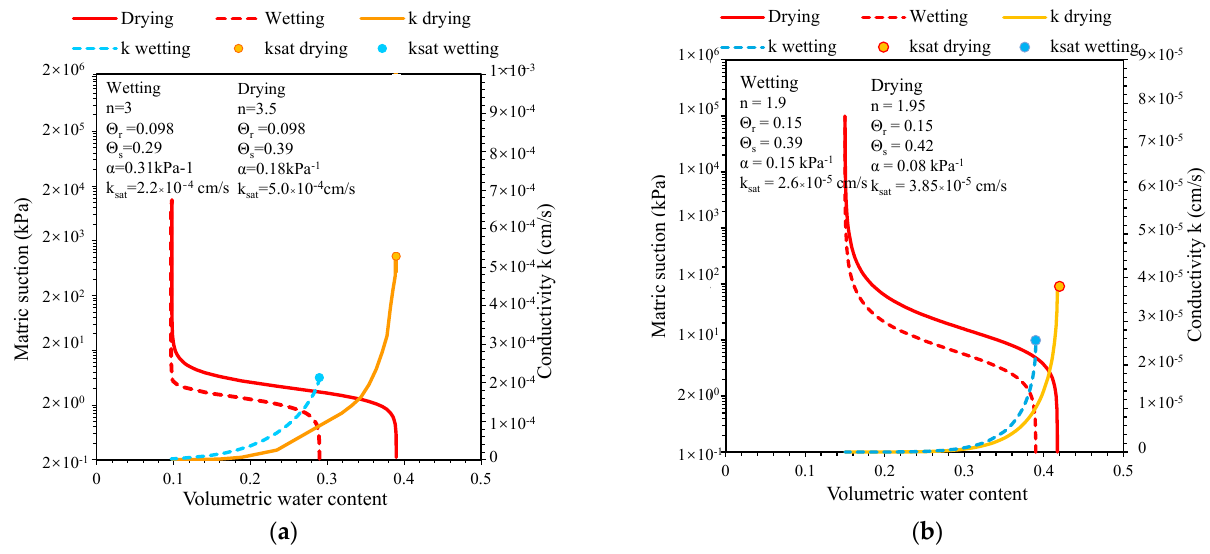
Figure 9. Soil–water characteristic curve and hydraulic conductivity function: ( a ) sliding body, ( b ) sliding zone.